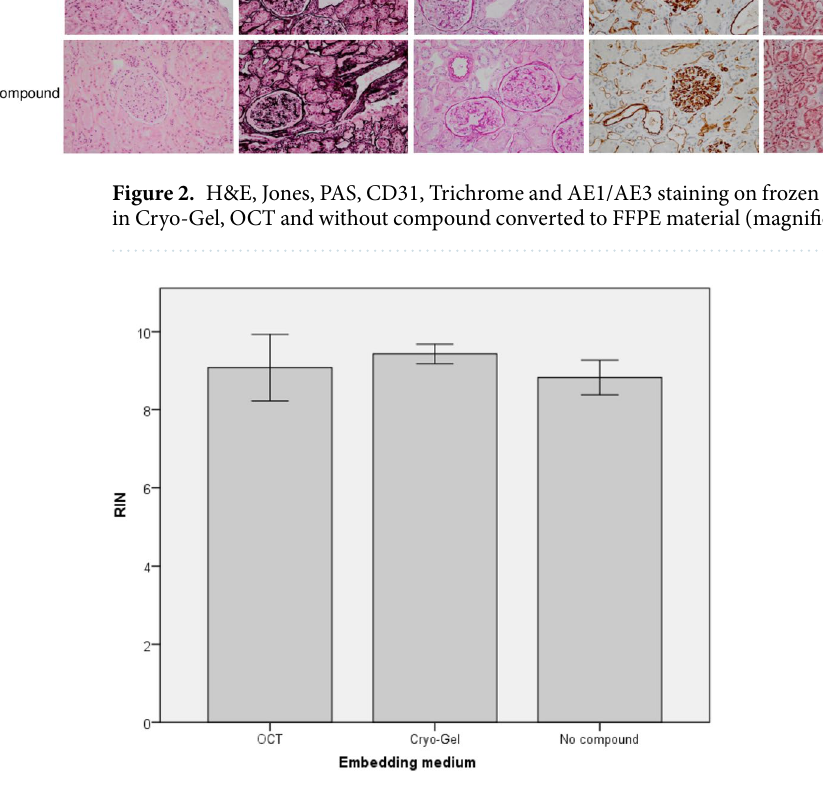
Figure 3. Mean RIN values for samples embedded in Cryo-Gel, OCT and without